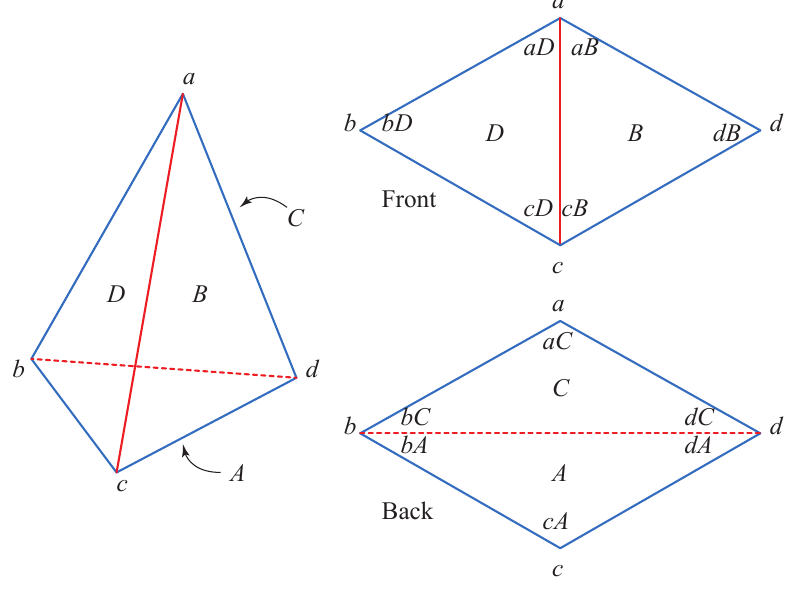
Figure 1. A = bdc , B = cda , C = adb , D = abc